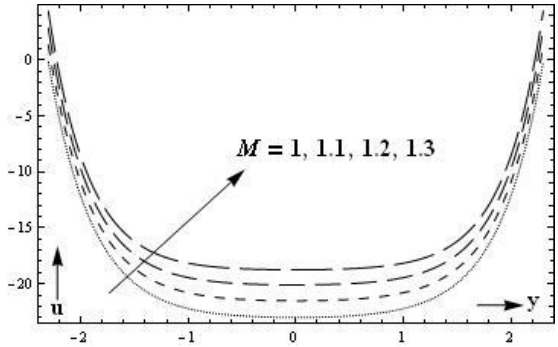
Figure 18 . Velocity profile for various values of magnetic